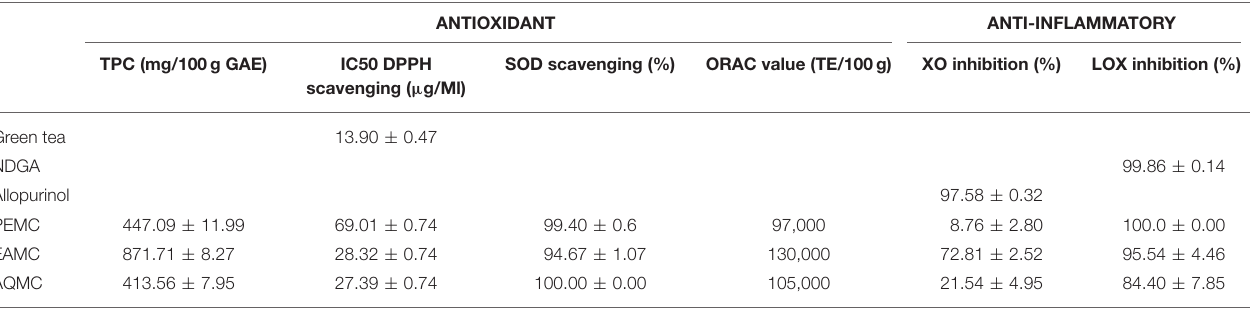
TABLE 1 | Antioxidant and anti-inflammatory activities of various partitions derived from methanol extract of M. calabura (MEMC), namely petroleum ether- (PEMC), ethyl acetate- (EAMC), or aqueous- (AQMC) partition of M. calabura . ANTIOXIDANT